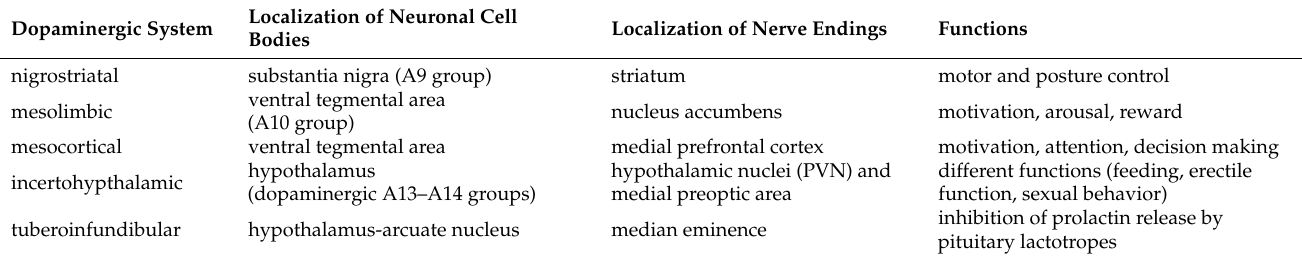
Table 1. Dopaminergic systems in the central nervous